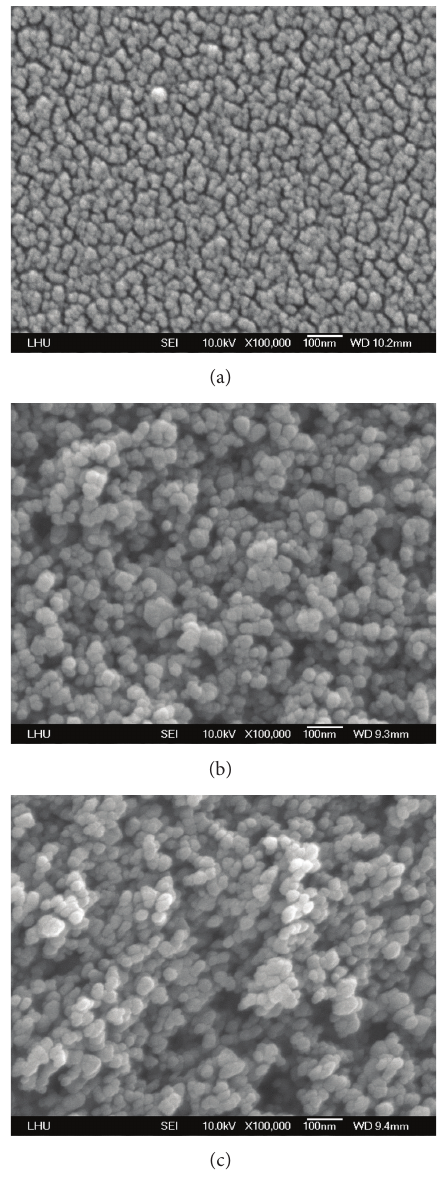
Figure 8: The SEM images of (a) sputtered TiO 2 compact layer on FTO/glass (sample number 8), (b) porous TiO 2 on TiO 2 compact layers/FTO/glass, produced using the sol-gel with spin coating method and (c) porous TiO 2 on compact TiO 2 layers/FTO/glass, produced using the sol-gel with blade coating